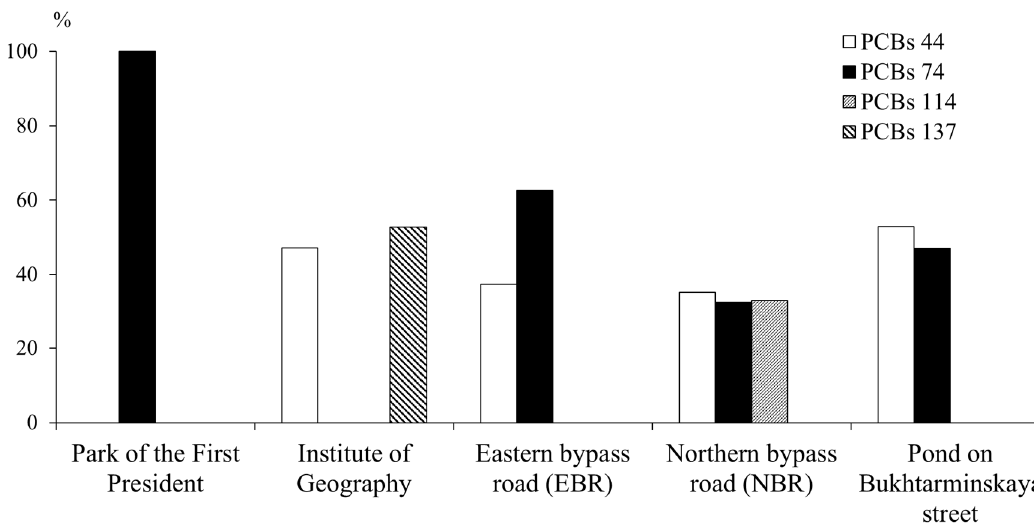
Figure 7. Relative content of PCB congeners in the snow cover of Almaty city in 2020.